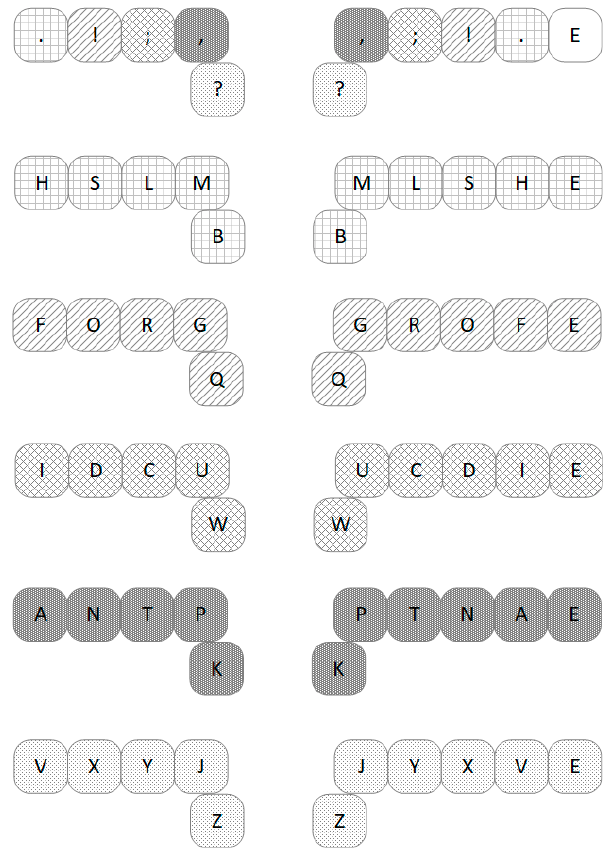
Figure 11. U-W-ORK+ arrangement.